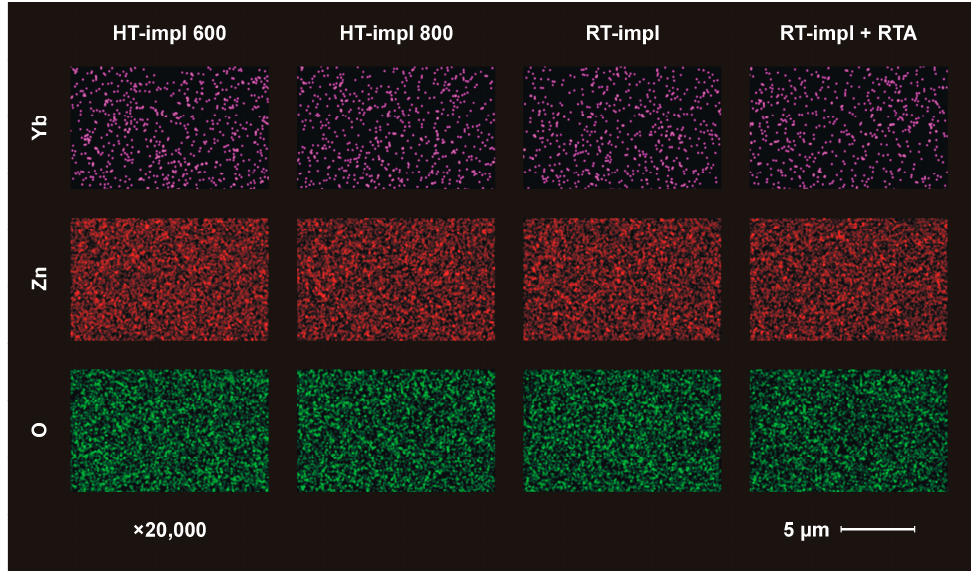
Figure 1. EDS mapping of Yb (pink), Zn (red), and O (green) for ZnO implanted with 150 keV Yb ions to the fluence of 1 × 10 15 /cm 2 was performed for samples implanted at different temperatures: 600 °C (HT-impl 600), 800 °C. (HT-impl 800), and RT (RT-impl) as well as implanted at RT and subsequently RTA-annealed for 10 min at 800 °C in an oxygen atmosphere (RT-impl +RTA).